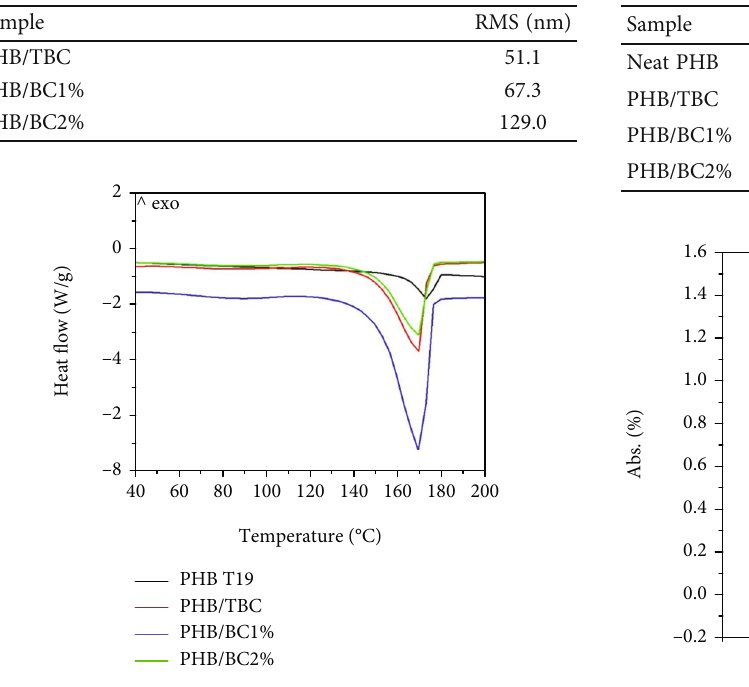
Figure 2: DSC thermograms for neat PHB, plasticized PHB, and PHB biocomposites ( fi rst heating scan).